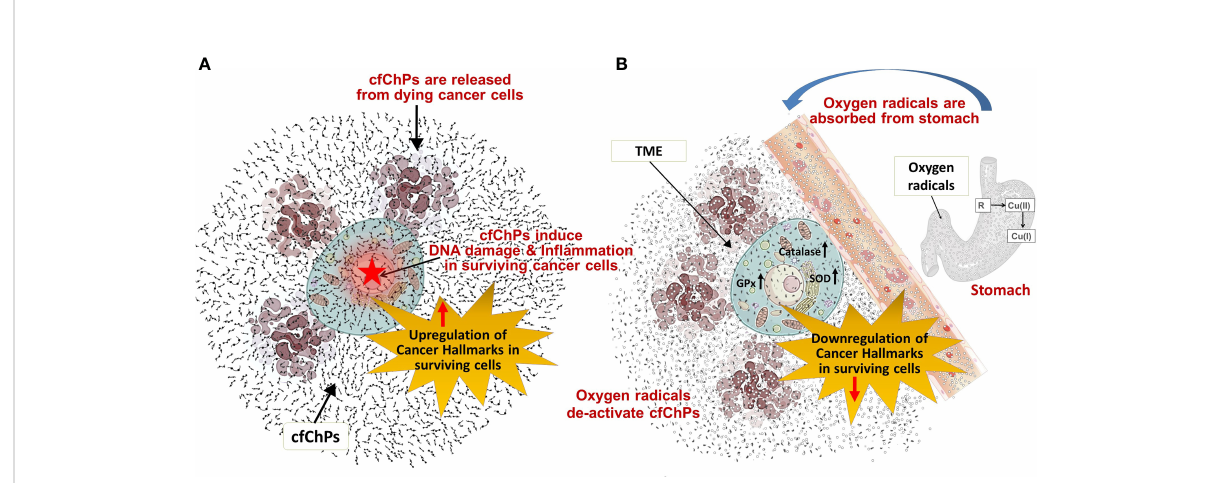
FIGURE 4 Graphical illustration of the mechanistic steps involved in oxygen radical induced down-regulation of cancer hallmarks. (A) cfChPs released from dying cancer cells induce DNA damage and in fl ammation, and up-regulate cancer hallmarks in surviving cancer cells. (B) Oxygen radicals generated upon oral ingestion of R-Cu are systemically absorbed from the stomach to reach TME leading to eradication of extra-cellular cfChPs and down-regulation of cancer hallmarks in surviving cells. Oxygen radicals also enter into the surviving cancer cells; but their cellular entry leads to activation of intracellular anti-oxidant enzymes which detoxify and eliminate the offending agents. SOD, superoxide dismutase; GPx, glutathione peroxidase; TME, tumour